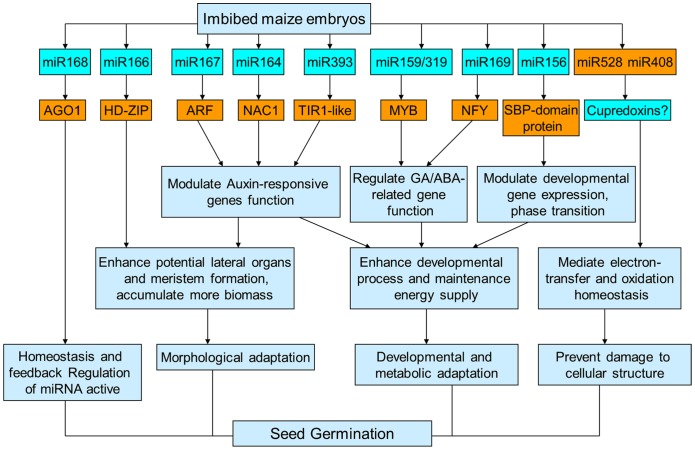
The potential regulatory network for miRNAs in maize dry and imbibed seed.The blue boxes represent down-regulated miRNA/genes and the orange boxes represent up-regulated miRNA/genes.